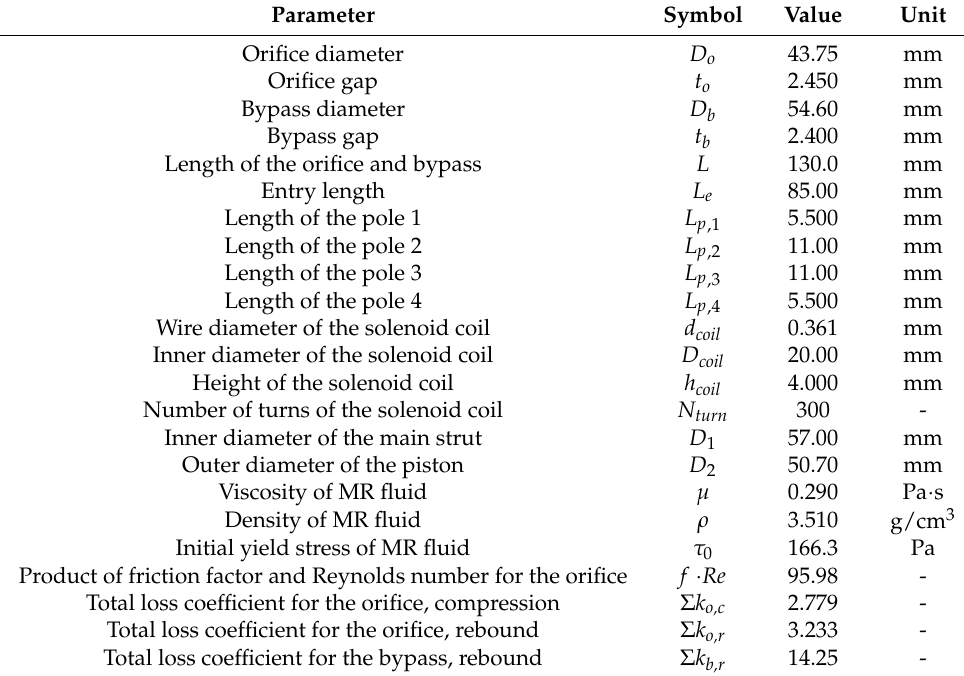
Table 1. Specifications of MR Shock absorber.